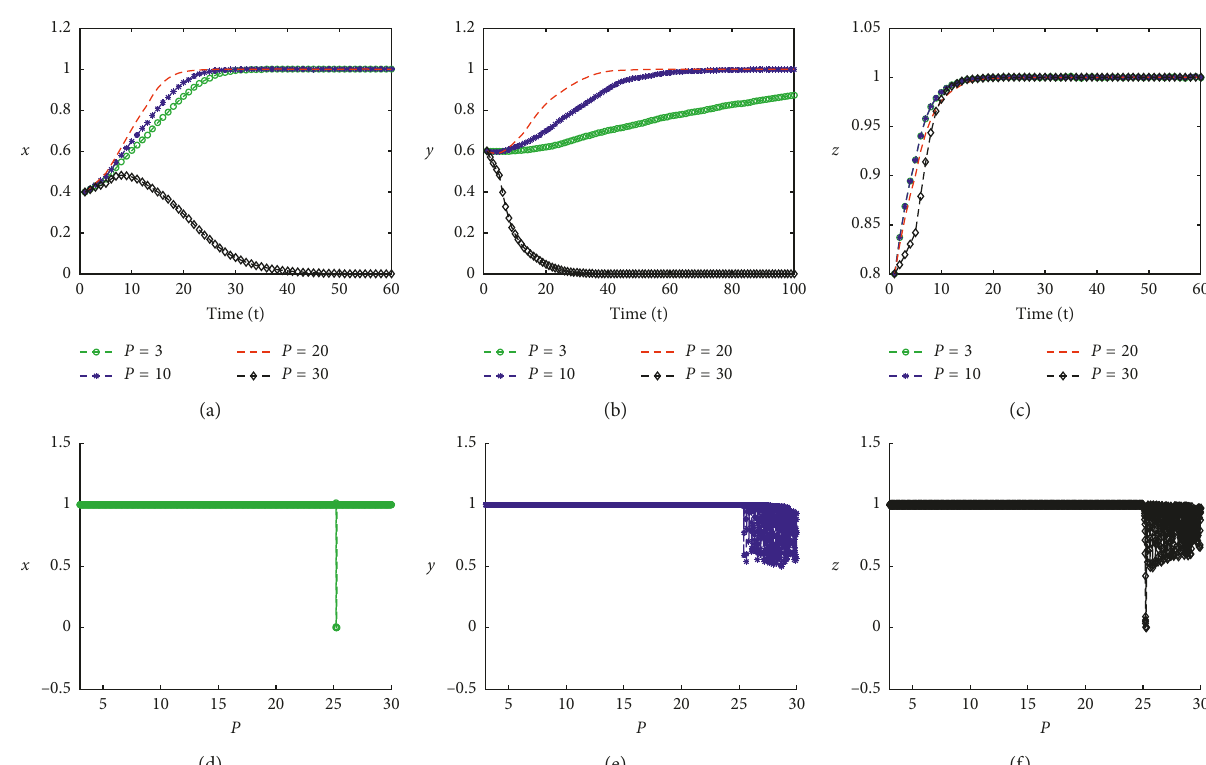
Figure 11: The effect of external investors’ investment amount on the evolutionary